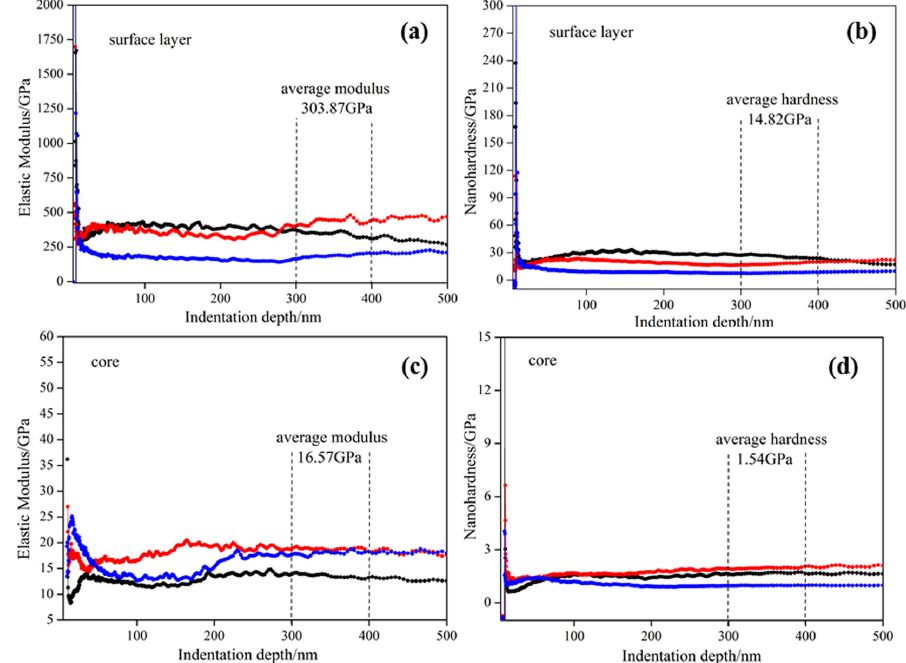
Figure 3. Elastic modulus-depth and nanohardness-depth curves of in situ transformed PAN-based carbon fibers: ( a ) elastic modulus-depth curve of the fiber surface layer; ( b ) nanohardness-depth curve of the fiber surface layer; ( c ) elastic modulus-depth curve of the fiber core; ( d ) nanohardness-depth curve of the fiber core.